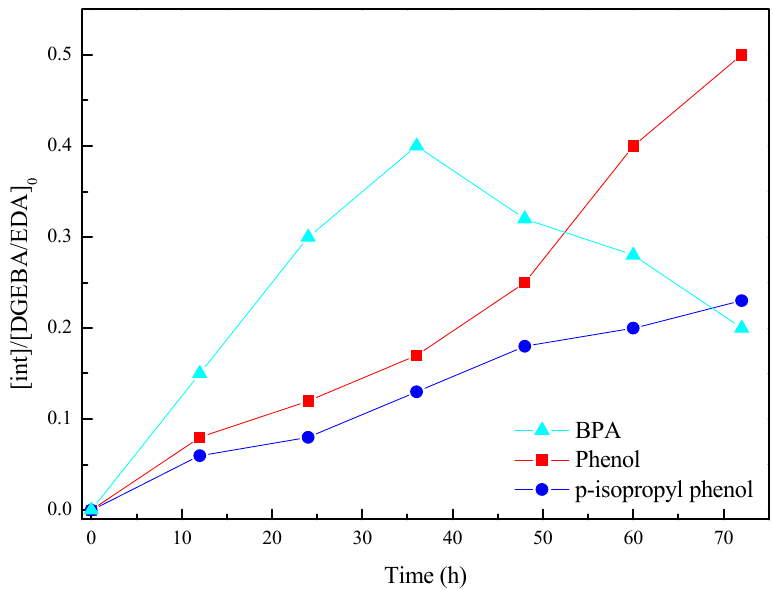
Figure 6. Yields of phenol, p-isopropyl phenol, and bisphenol A (BPA) produced by the degradation of epoxy resin with reaction time.